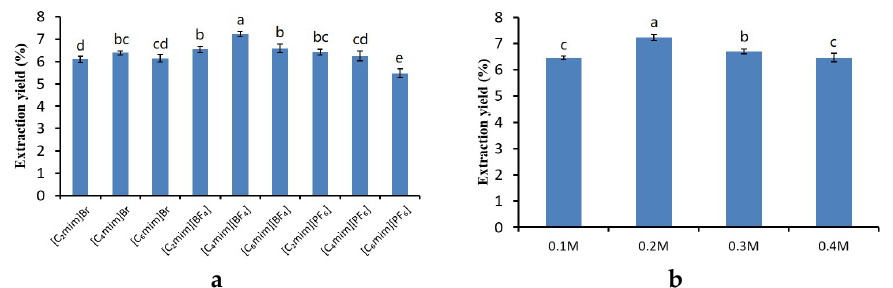
Figure 1. ( a ) Effects of ionic liquids (ILs) with different anions and cations on extraction yields of total ginsenosides; ( b ) Effects of [C 4 mim][BF 4 ] with different concentrations on extraction yields of total ginsenosides. Different letters in the same series indicate significant difference at p < 0.05.